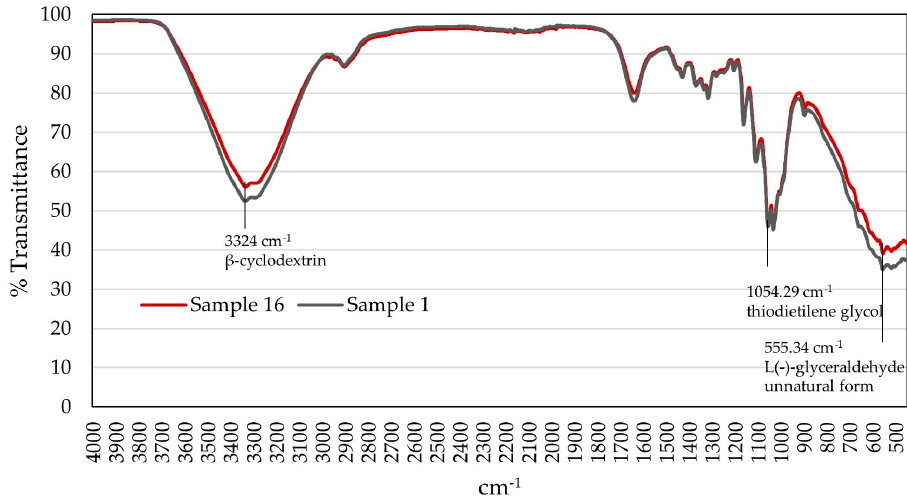
Figure 2. Transmittance reads of samples 16 (with detected thiodiethylene glycol) and 1 (without detected thiodiethylene glycol) at full FT-IR spectra from 450 to 4000 cm − 1 .